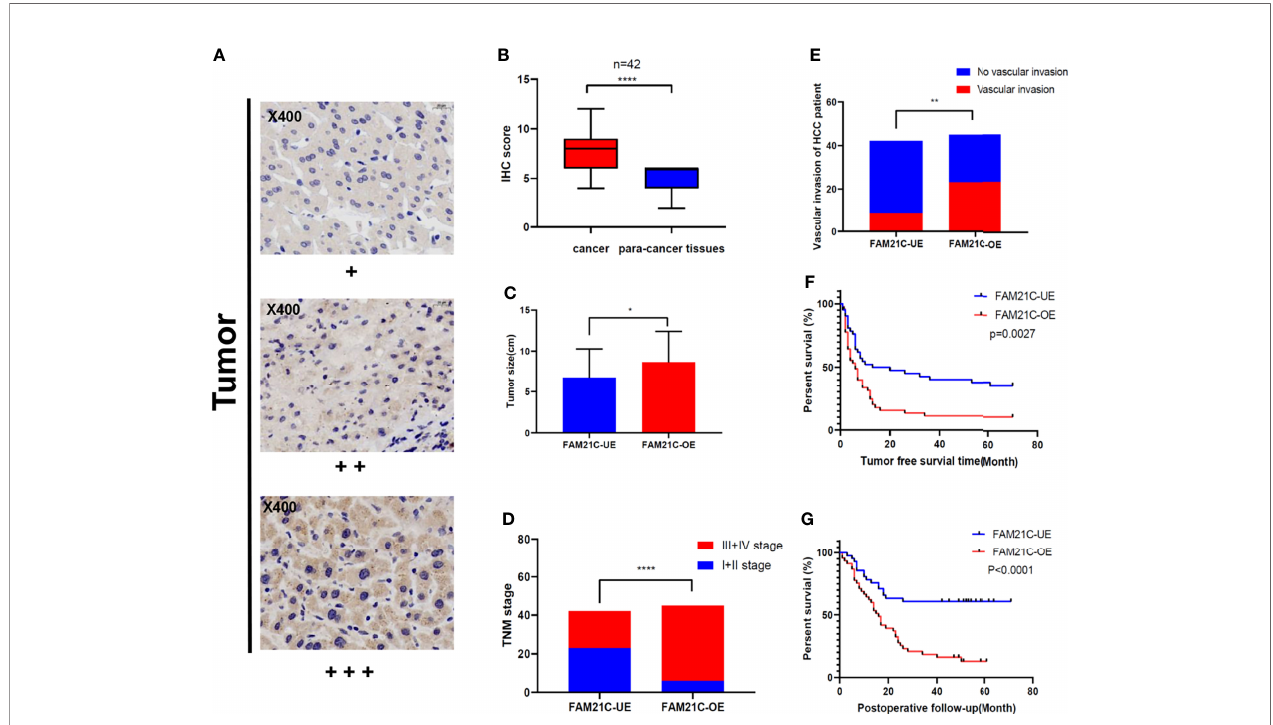
FIGURE 2 | Up-regulated expression of FAM21C promotes the malignant progression of HCC in patients. (A) Immunohistochemical staining was performed in 129 HCC tissue. The stain intensity was classi fi ed as weak (+), moderate (++), or strong intensity (+++). Representative images are presented. FAM21C expression was scored according to intensity and area as described in the Materials and Methods. (B) The expression of FAM21C levels in 42 paired HCC tissue analyzed by paired Student ’ s t test. (C) The mean tumor size in HCC patient of the FAM21C low-expression and high-expression group; red indicates the overexpression and blue indicates the low-expression. (D) Tumor stage in HCC patients of the FAM21C overexpression and low-expression groups; red indicates the III+IV stage, and blue indicates I+II stage. (E) Vascular invasion in HCC patients of the FAM21C overexpression and low-expression groups; red indicates the occurrence of vascular invasion, and blue indicates no vascular invasion. (F, G) The Kaplan – Meier analysis of DFS and OS between FAM21C low-expression group and overexpression group. * P < 0.05, ** P < 0.01, **** P <